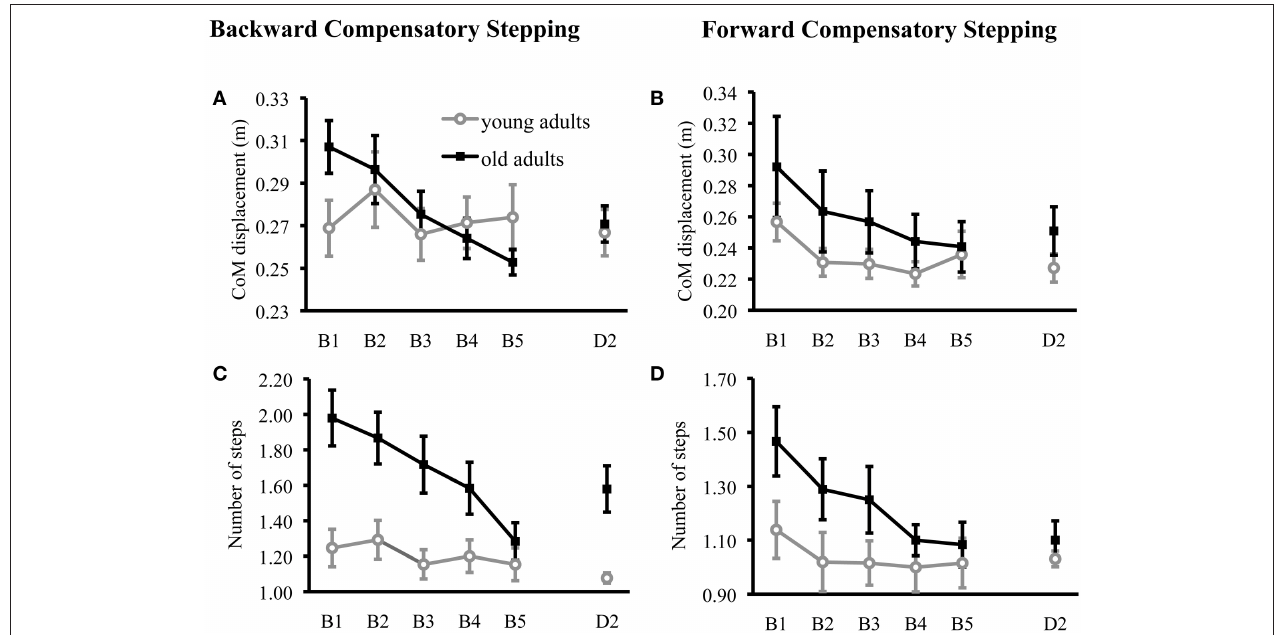
FIGURE 1 | Forward and backward compensatory step performance. Center of mass displacement (CoM) in the anteroposterior direction for healthy young and healthy older adults during compensatory backward (A) and forward (B) stepping are displayed for the motor training (block 1: B1–block 2: B2) and the retention test on day 2 (D2). Number of steps are displayed for young and older adults during compensatory backward (C) and forward (D) stepping are displayed for the motor training and the retention test on day 2. Values are represented as group mean with SE.